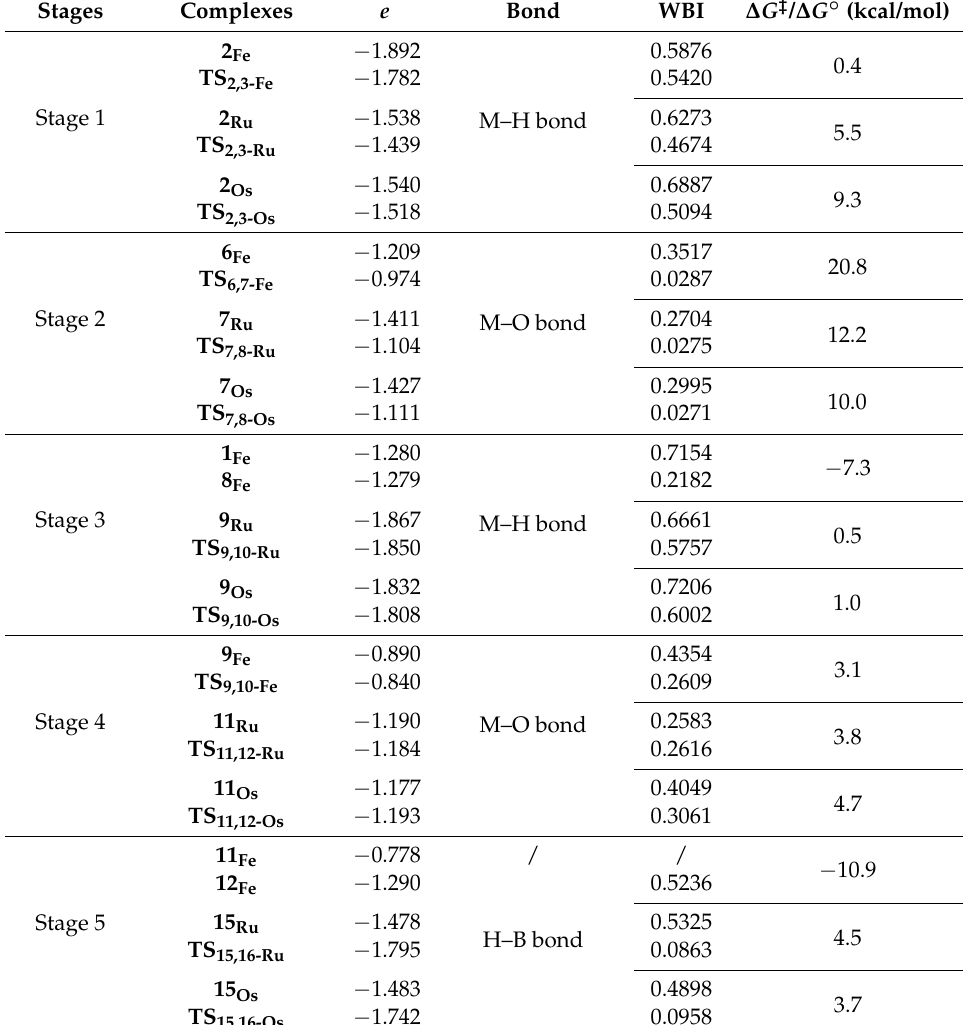
Table 1. The natural population analysis (NPA) charges of metal atoms ( e ), the Wiberg bond indices (WBIs) of the bonds, the relative free energies between intermediates and transition states/intermediates ( ∆ G ‡ / ∆ G ◦